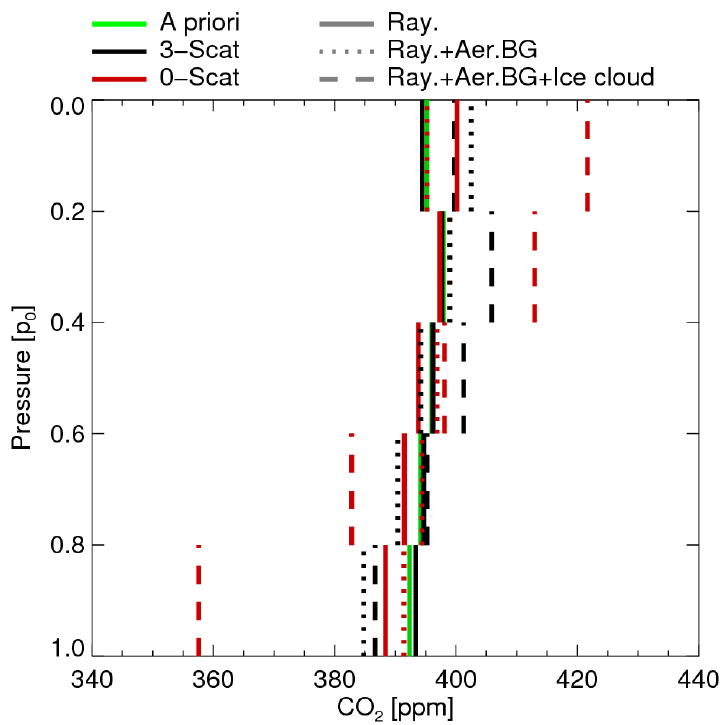
Figure 13. Retrieved and a priori CO 2 profiles for the 0-Scat and 3-Scat retrieval setups and the geophysical scenarios Rayleigh , Rayleigh+AerosolBG , and Rayleigh+AerosolBG+Icecloud ( θ 0 = 40°, perpendicular